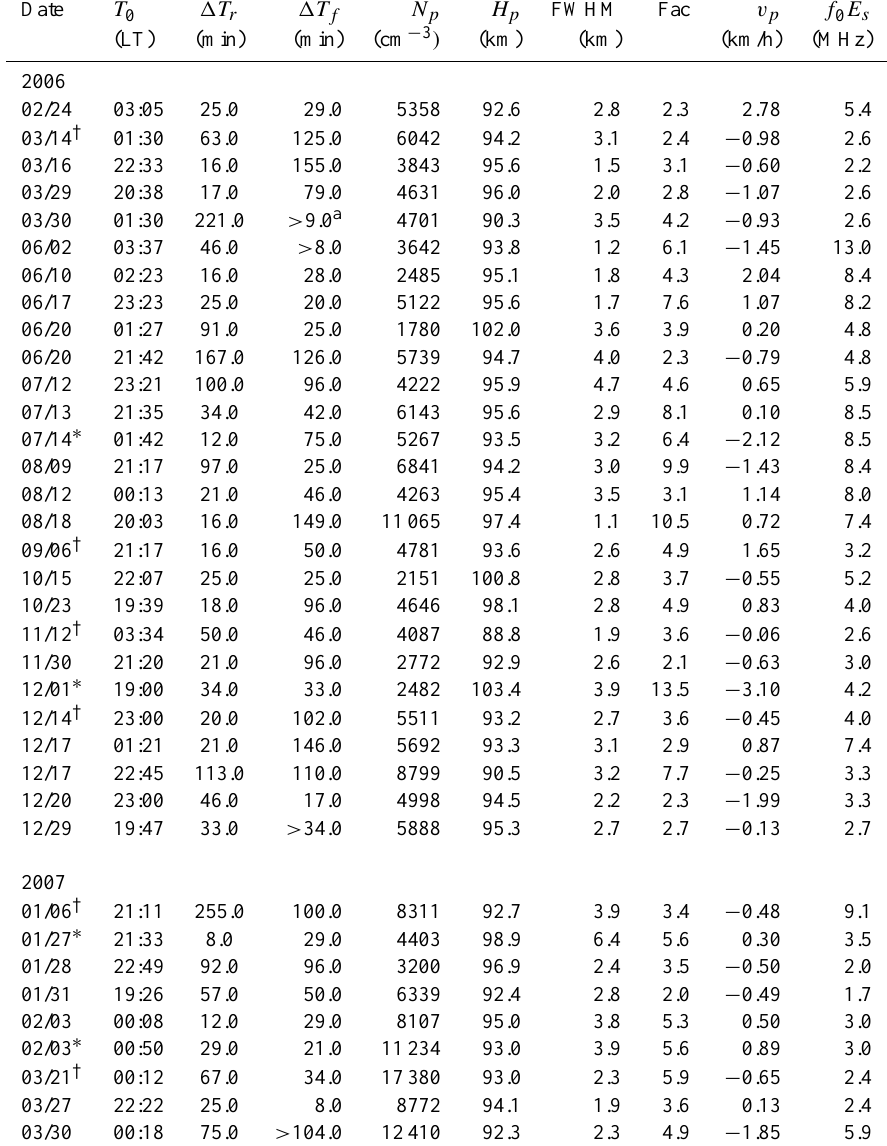
Table 2. List of the SSL events during